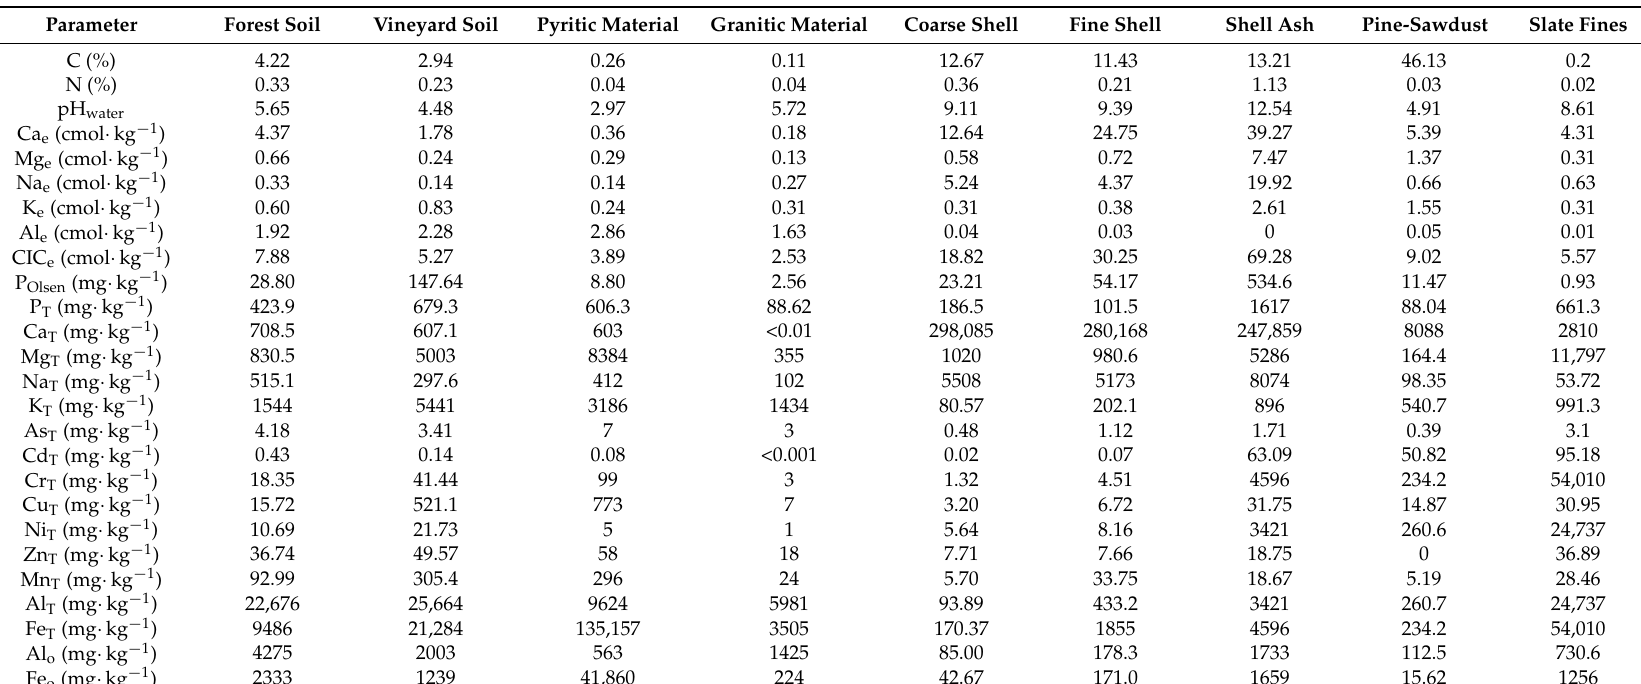
Table 1. General characteristics of the soils and the sorbent materials (average values for 3 replicates, with coefficients of variation always